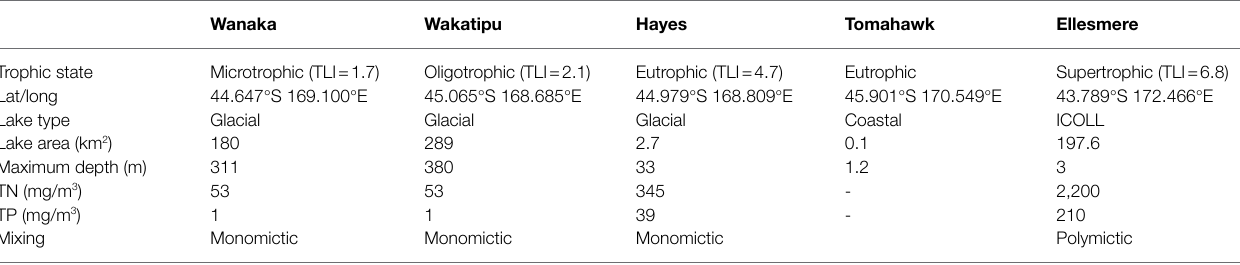
TABLE 2 | Lake characteristics and typical water quality